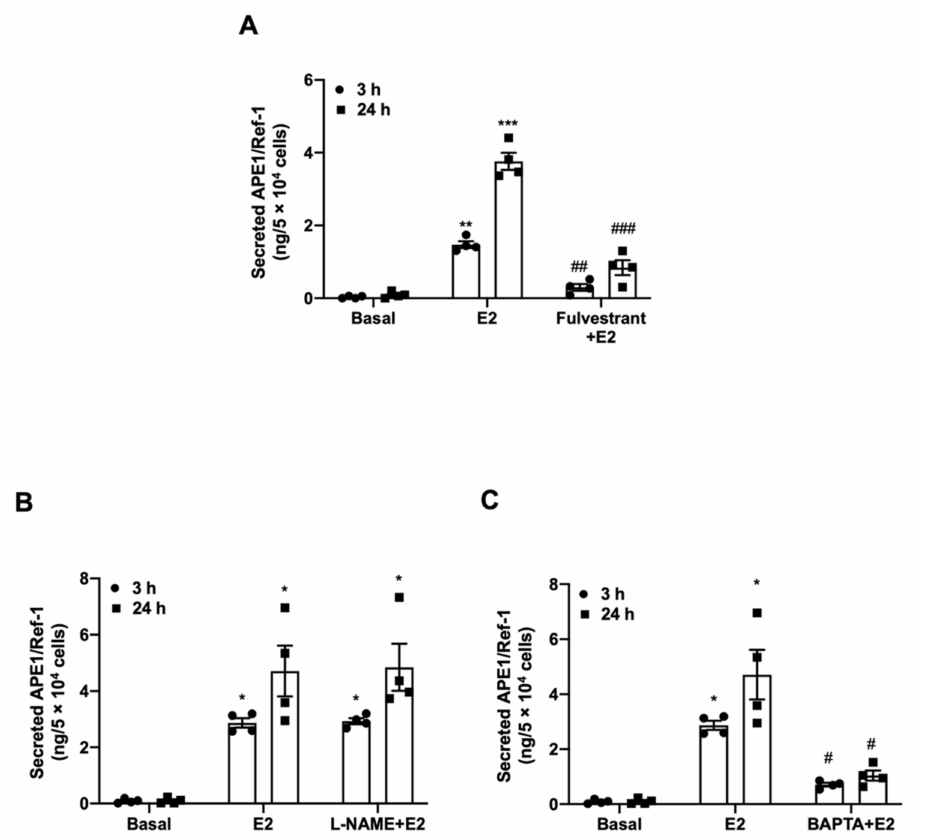
Figure 4. 17 β -estradiol (E2)-induced apurinic/apyrimidinic endonuclease-1/redox factor-1 (APE1/Ref-1) secretion depends on estrogen receptor binding and intracellular calcium. ( A ) Ef- fect of the competitive estrogen receptor (ER) inhibitor fulvestrant (100 nM for 2 h) on E2-induced APE1/Ref-1 secretion in cultured endothelial cells. ( B ) Effect of the endothelial nitric oxide syn- thase inhibitor N( ω )-nitro-L-arginine methyl ester (L-NAME) (10 mM for 1 h) on 17 β -estradiol (E2)-induced APE1/Ref-1 secretion in cultured endothelial cells. ( C ) Effect of the cell permeable calcium chelator 1,2-Bis(2-aminophenoxy)ethane-N,N,N (cid:48) ,N (cid:48) -tetraacetic acid tetrakis (acetoxymethyl ester) (BAPTA-AM) (10 µ M for 30 min) on E2-induced APE1/Ref-1 secretion in cultured endothe- lial cells. Columns, mean (n = 4); dot plot, SE. *** p < 0.001, ** p < 0.01, and * p < 0.05 vs. Basal; ### p < 0.001, ## p < 0.01, and # p < 0.05 vs. E2 treated based on one-way ANOVA analysis followed by Bonferroni’s multiple comparison